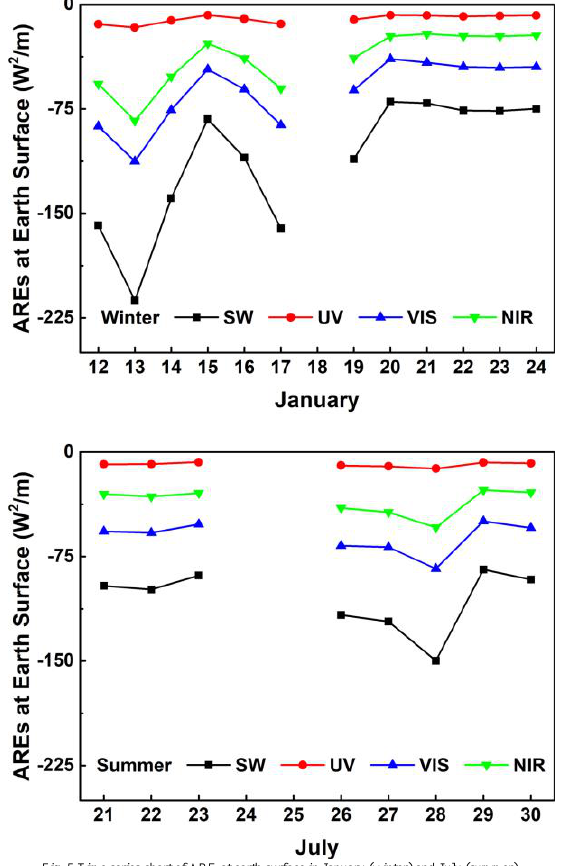
from -8.29 W/m 2 to -10.88 W/m 2 , from -43.26 W/m 2 to -66.04 W/m 2 , from -21.90 W/m 2 to -44.57 W/m 2 , and from -73.46 W/m 2 to -119.49 W/m 2 respectively in winter. And it changed in summer from -8.32 W/m 2 to -11.06 W/m 2 , from -56.33 W/m 2 to -76.94 W/m 2 , from -31.36 W/m 2 to -48.67 W/m 2 , and from - 96.01 W/m 2 to -135.67 W/m 2 respectively.